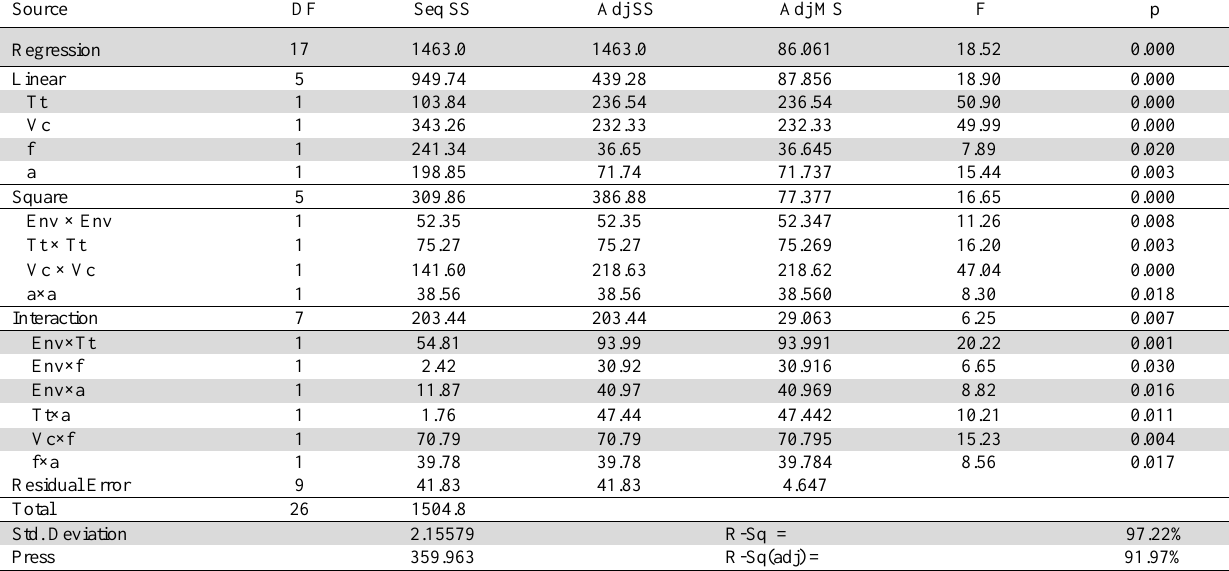
Analysis of Variance results for Material Removal Rate (MRR) (Significant terms Only)